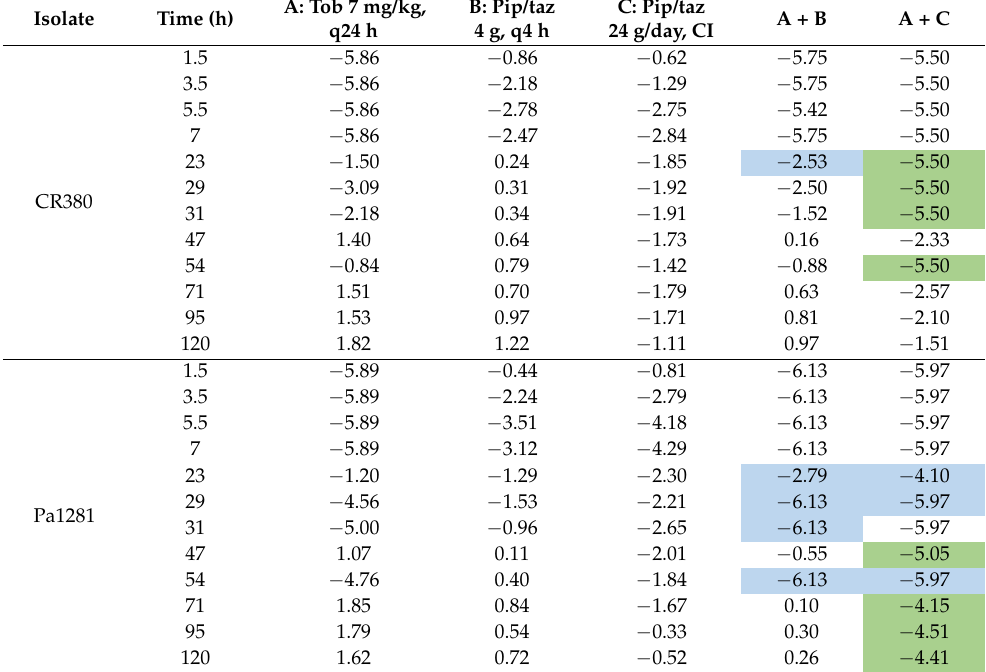
Figure 3. Less susceptible subpopulations of CR380 (average ± SE a ) in the dynamic in vitro infection model detected on antibiotic-containing agar plates. The total population is representative of what is shown in Figure 1. Observations below the limit of counting (0.7 log 10 CFU/mL) are plotted at 1.0 log 10 CFU/mL. a Performed in biological replicates, n = 2, except for treatment arms B and A + B where n = 3. Table 2. Log change for each treatment as a function of time from the dynamic in vitro infection